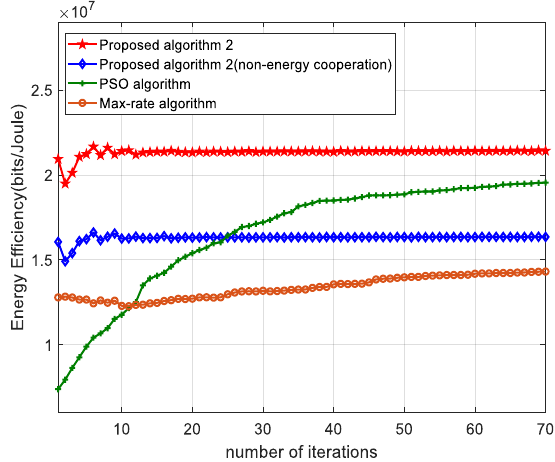
Figure 2. Convergence performance of different algorithm.